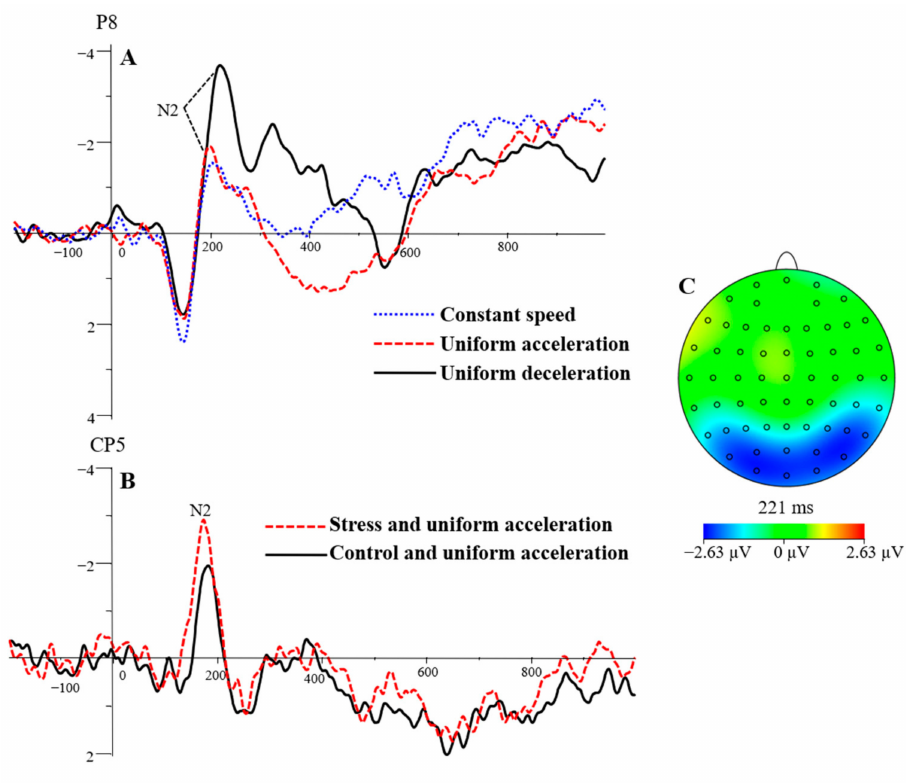
Figure 5. The grand average waveform for N2 at speed types ( A ) and stress levels ( B ). The differences between the UD and UA were shown in the topographic map ( C